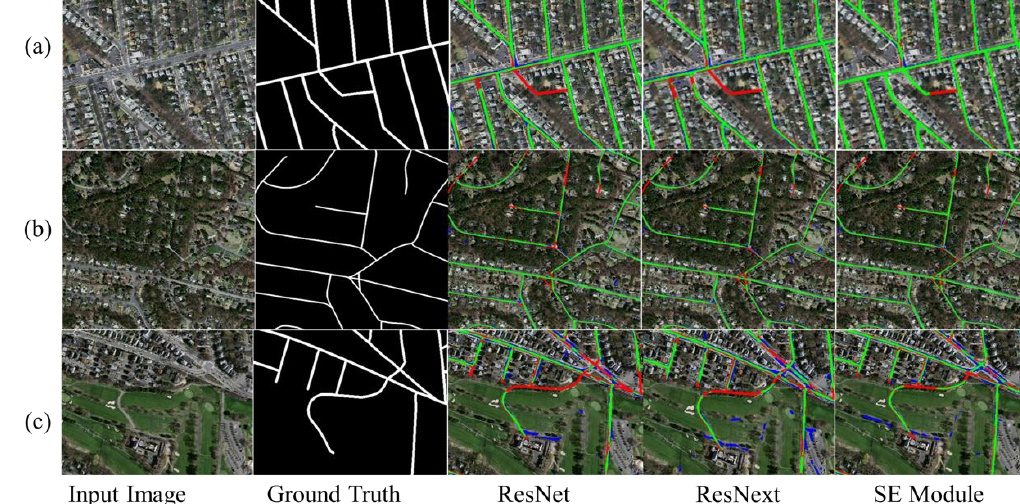
Figure 11. Magnification of the results in Figure 10. True positive (TP) is marked as green, false positive (FP) as blue, and false negative (FN) as red. Each subfigure in this figure is the magnification of the results shown in Figure 10.